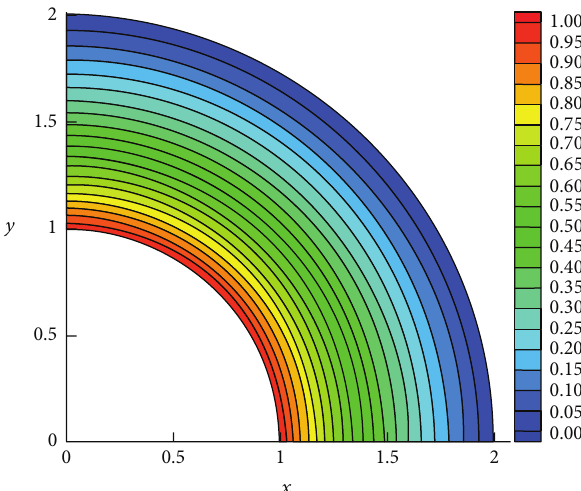
Figure 14: Distribution of tangential velocity 𝑢 𝜃 .